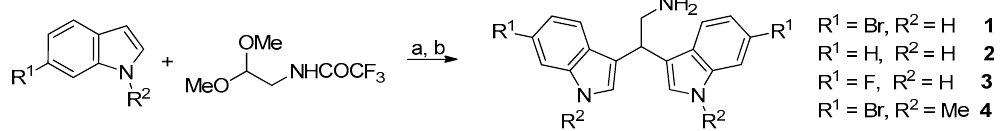
Figure 3. Reaction conditions: ( a ) diphenyl phosphate, acetonitrile, 80 ◦ C, 24 h; ( b ) K 2 CO 3 , methanol, reflux, 2 h.